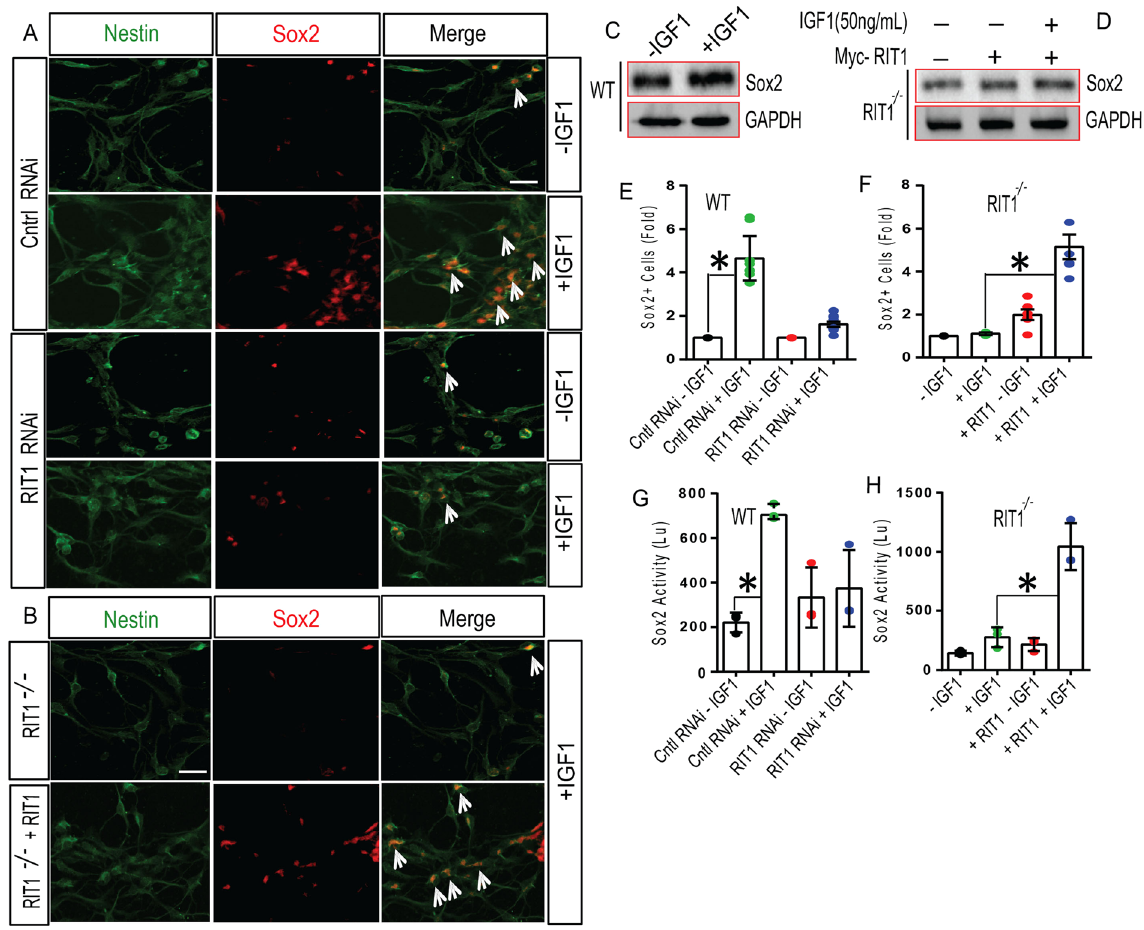
Figure 6. RIT1 contributes to IGF-1-mediated Sox2 stabilization and transcriptional activation. ( A ) Representative confocal images of Sox2 + cells from WT HNPC cultures left untreated (-IGF1) or treated with IGF-1 (50 ng/ml; 24 h) (Scale bar, 15 μ m) following infection with either control (Cntl) or RIT1 -directed RNAi ( RIT1#2 ) and co-immunostained with Nestin ( green ) and Sox2 ( red ). The arrowheads ( white ) indicate HNPCs that express Sox2. ( B ) Representative micrographs of Sox2 expression in RIT1 − / − HNPCs, with and without re- expression of Myc-RIT1 following IGF-1 (50 ng/ml; 24 h) stimulation (Scale bar 15 μ m). ( C ) Immunoblotting for SOX2 in WT HNPCs with or without stimulation with IGF-1 (50 ng/ml; 24 h). Representative images were cropped from the original blots run in parallel. ( D ) Immunoblotting for SOX2 levels in RIT1 − / − HNPCs in the presence of transiently transfected Myc-RIT1 and IGF-1 stimulation (50 ng/ml; 24 h). Representative images were cropped from the original blots run in parallel. ( E , F ) Quantification (fold-change) of Sox2 + cells in the indicated HNPC cultures following IGF-1 stimulation (50 ng/ml; 24 h) are presented as mean ± SEM ( * p < 0.05, one-way ANOVA). ( G , H ) Quantification of Sox2 luciferase reporter activity in cultured WT, RIT1 − / − , or RIT1 − / − HNPCs following Myc-RIT1 complementation, with or without IGF-1 stimulation (50 ng/ml, 24 h) are presented as mean ± SEM from three separate experiments ( * p < 0.01, one-way